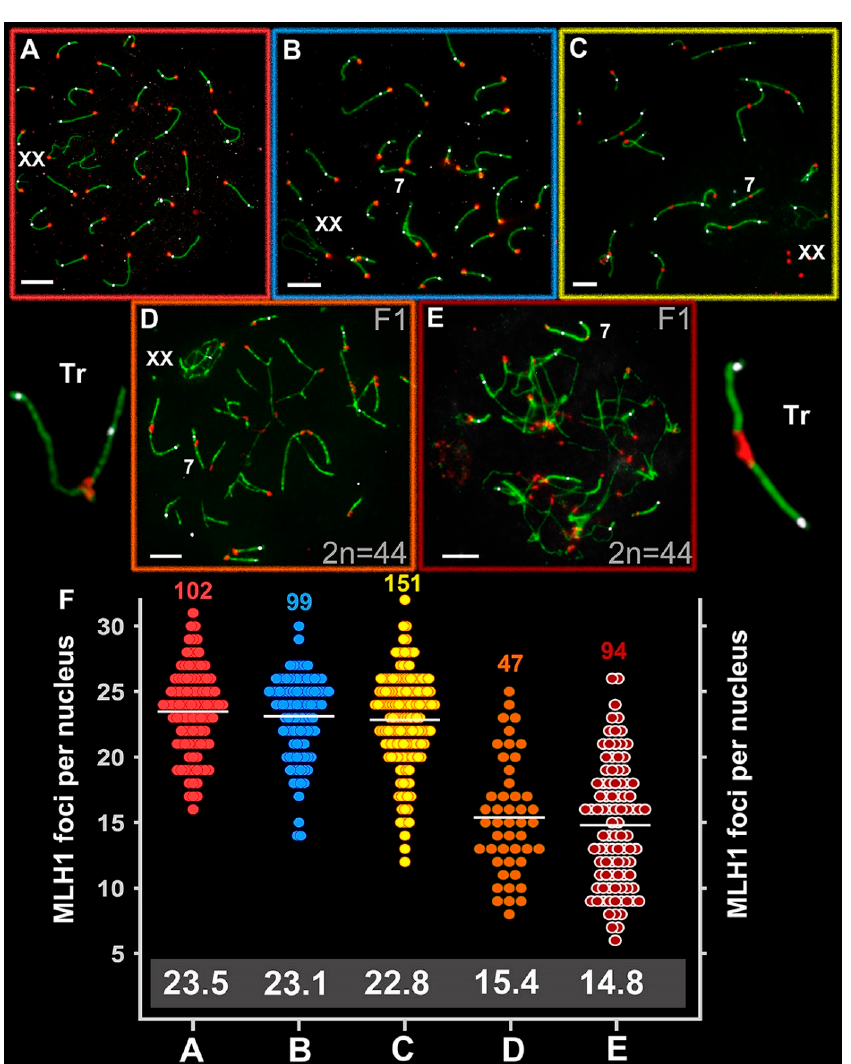
Figure 5. Recombination in Ellobius species and hybrid males. Axial elements were identified using anti-SYCP3 antibodies (green), kinetochores using CREST antibodies (red), and anti-MLH1 (white) was used as a marker of recombination nodules. ( A ) E talpinus (2 n = 54, NF = 54); ( B ) E. tancrei (2 n = 54, NF = 56); ( C ) E. tancrei (2 n = 34, NF = 54); ( D ) F1 E. tancrei × E. tancrei hybrid; ( E ) F1 hybrid E. talpinus × E. tancrei hybrid. ( F ) Comparison of MLH1 foci per nucleus in mole voles: the numbers above the dot diagrams correspond to the number of counted cells. White numbers in a gray frame correspond to the average number of MLH1 foci. Table S1 presents details on significant statistical differences between species and hybrids. Scale bars represent 5 μ m.